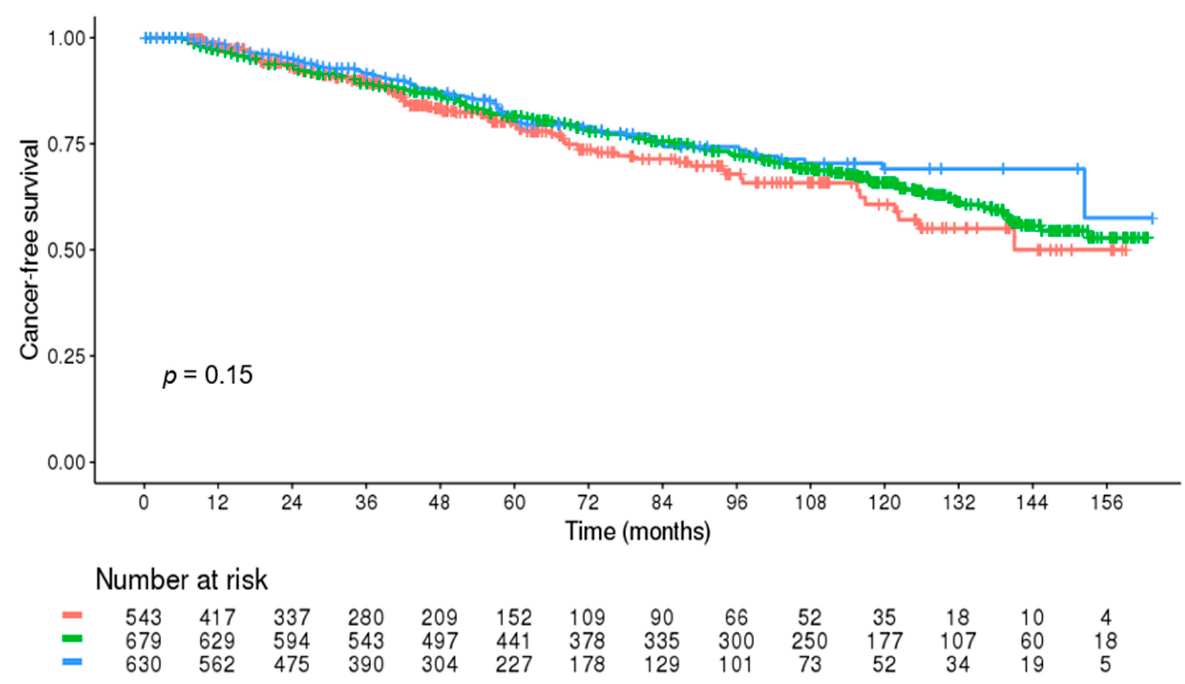
Figure 3. Cancer-free survival during the long-term follow-up in the patients without cancer until after 6 months after the index date (red line: abdominal aortic aneurysm group; green line: heart failure group; blue line: control group). Table 5. Comparison of the mortality